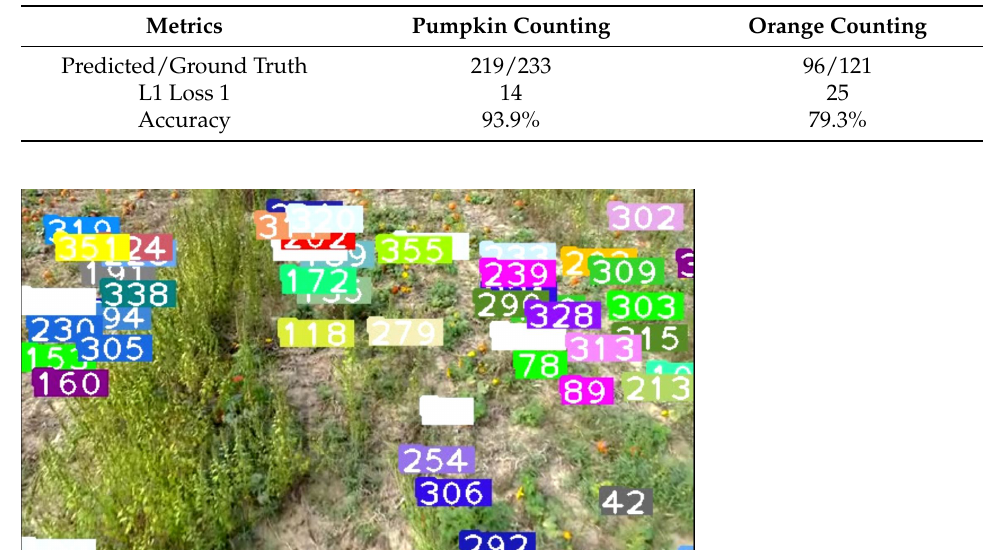
Table 7. Results of the proposed pipeline running on a video clip of pumpkins and oranges. The oranges are counted using pretrained YOLO weights and thus produce a lower accuracy of 79.3%. Since pumpkins are trained specifically on aerial views of pumpkins, including a sample from the experiment video, the accuracy was quite high.